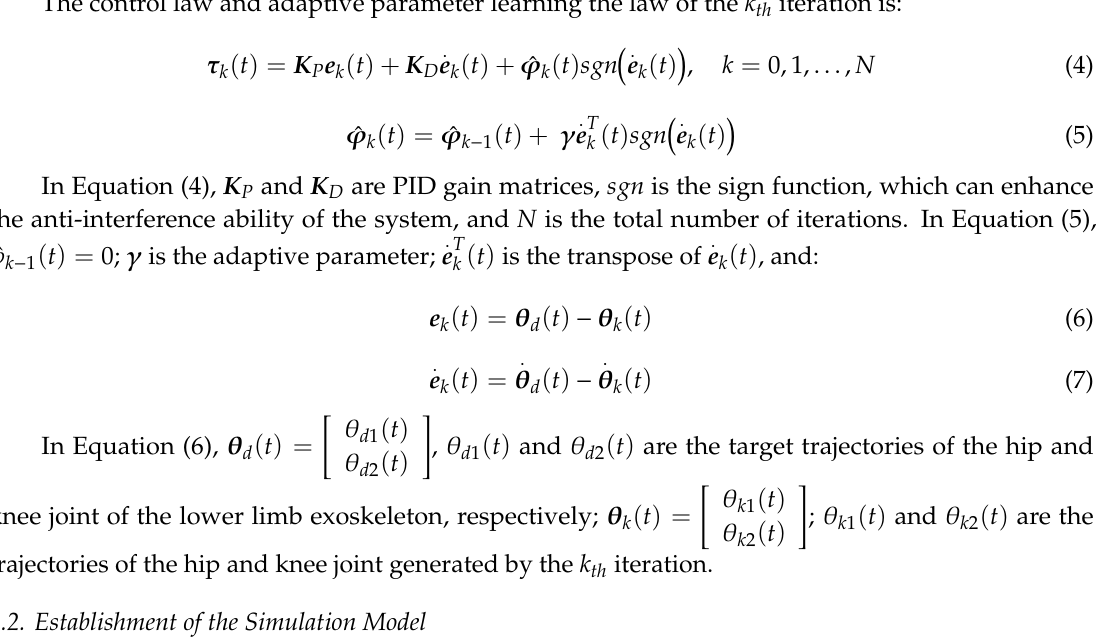
Figure 2. The schematic diagram of the adaptive iterative learning control (AILC).